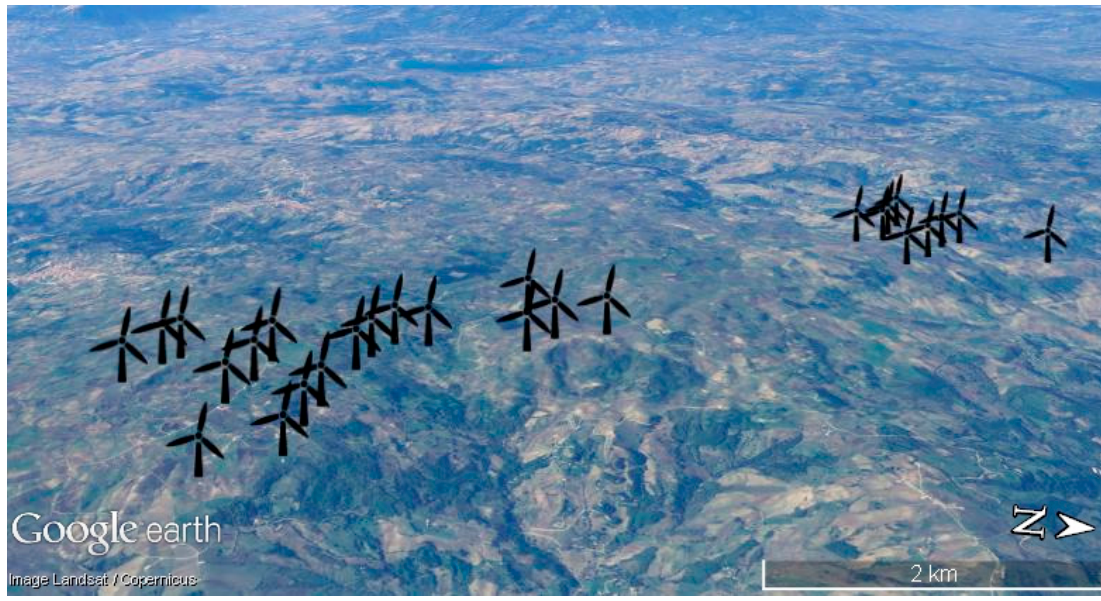
Figure 4. Satellite view of the analyzed area.